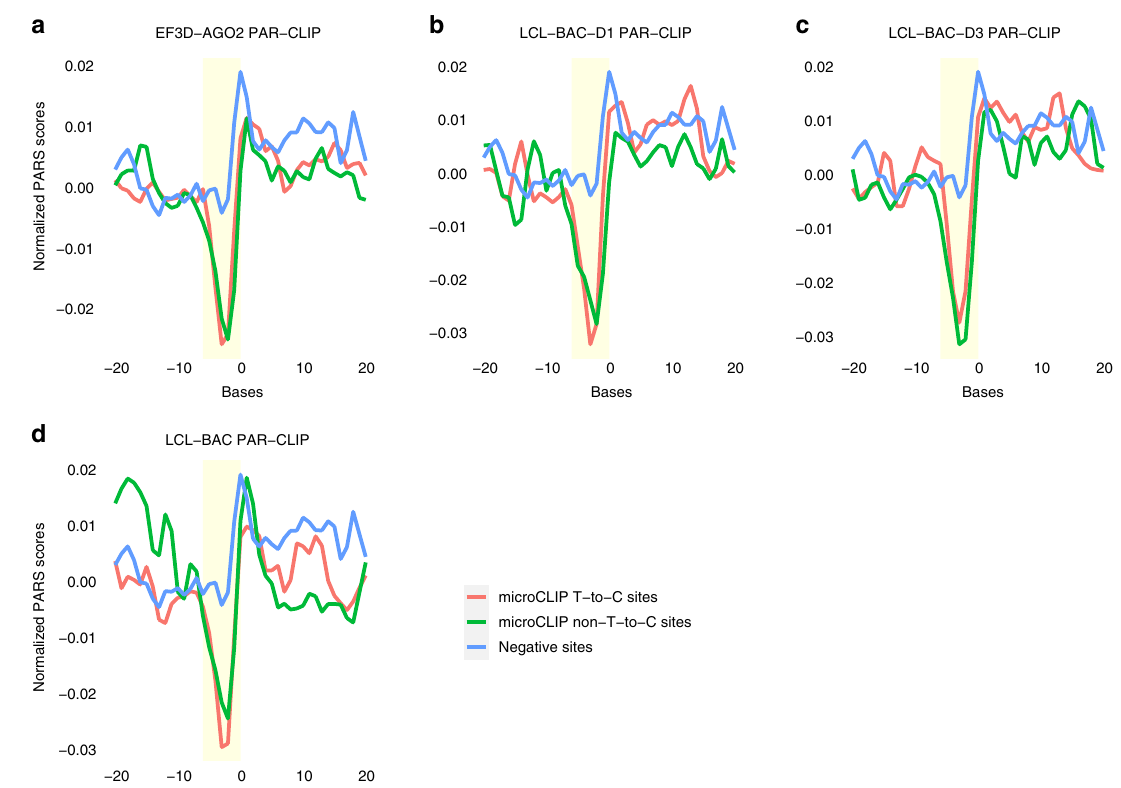
Fig. 4 Average PARS scores of AGO-bound regions deduced from the analysis of 4 EBV transformed lymphoblastoid PAR-CLIP libraries. RSS base signals were aligned to the start of the miRNA-target binding site. Base 0 corresponds to the 3 ′ -end of the mRNA, at − 1 or − 2 nt downstream of the initiation of the direct miRNA seed pairing. Negative PARS scores correspond to single stranded RNA structures, while positive scores to double stranded sites. In the examined AGO-PAR-CLIP EF3D-AGO2 ( a ), LCL-BAC-D1 ( b ), LCL-BAC-D3 ( c ), and LCL-BAC ( d ) datasets, strong structural accessibility occurs in miRNA sites identi fi ed on T-to-C (red) and non-T-to-C (green) clusters in the 2 – 4 nt positions (yellow window) of the miRNA seed pairing. These results signi fi cantly differ from respective base scores along negative MREs (light blue) located on AGO-enriched peaks. Statistical signi fi cance of position structural changes was calculated using two-tailed Wilcoxon rank-sum